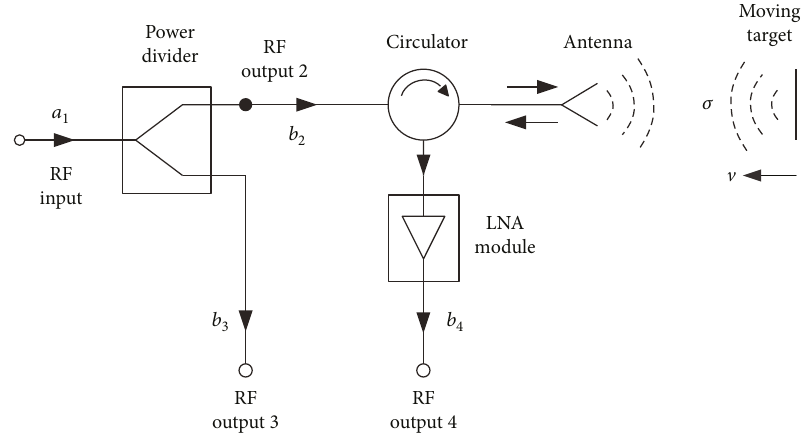
Figure 1: Simpli fi ed block diagram of the front end of a monostatic Doppler